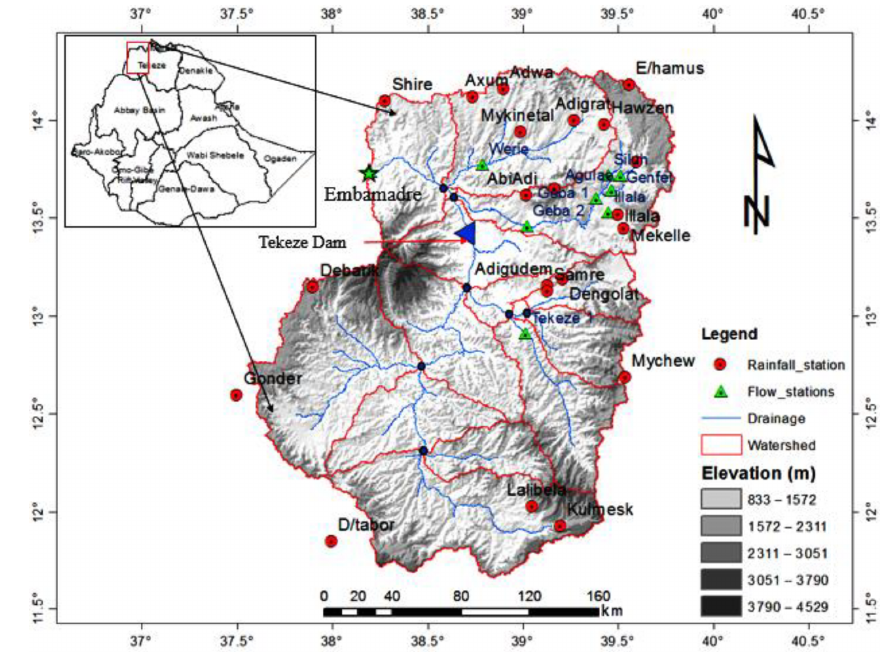
Figure 1. Location and distribution of rainfall and streamflow monitoring stations in the Upper Tekez¯e–Atbara river